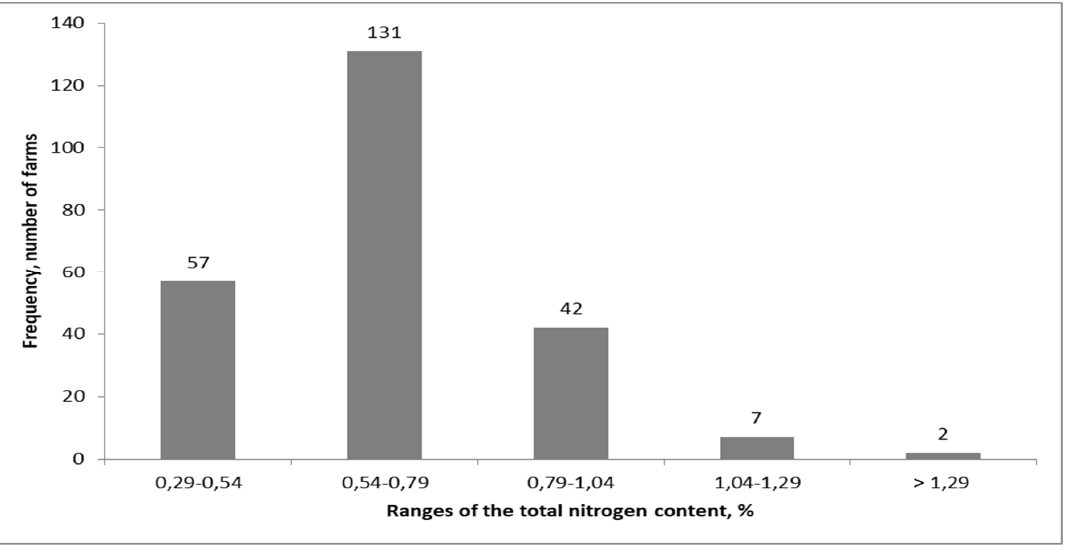
Figure 2. The frequency of the nitrogen content variability in farmyard manure in West Poland (non-published results by Przygocka ─ Cyna).